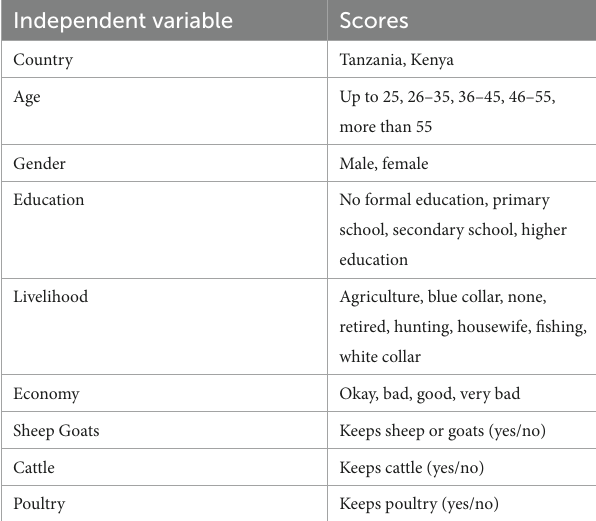
TABLE 2 Independent variables